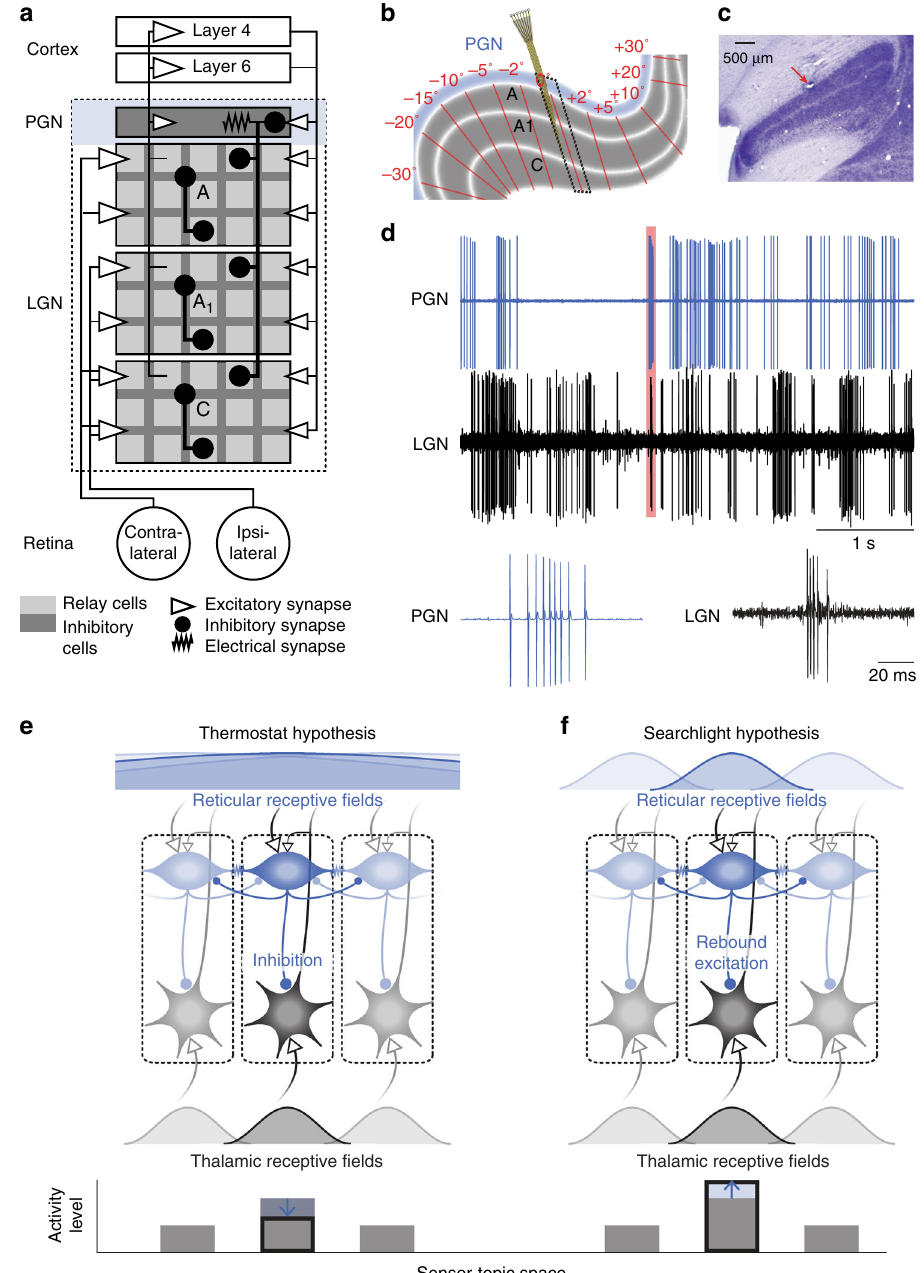
Fig. 1 Neural circuits and sample recordings from the visual thalamus (PGN and LGN) of the cat. a The PGN and main layers of the LGN drawn as rectangles including populations of excitatory ( light fi ll ) and inhibitory neurons ( dark fi ll ). Glutamatergic synapses ( open arrows ); GABAergic synapses ( fi lled circles ) and electrical synapses (resistor). b Parasagittal section of the visual thalamus; the layers of the LGN ( gray ) and the PGN ( blue ). Red lines and corresponding text mark retinotopic position 7 ; dashed box illustrates a single retinotopic location sampled by the multi-electrode. c Nissl-stained coronal section showing a recording site ( red arrow ). d Recordings from a neuron in the PGN ( blue ) and a relay cell in the LGN ( black ) with bursts ( red ) shown at an expanded time scale. Illustrations of the ( e ) thermostat and ( f ) searchlight hypotheses. Boxes with dashed outlines represent local circuits for adjacent regions of the visual fi eld; excitatory, inhibitory, and electrical synapses as above. For the thermostat hypothesis ( e ), reticular feedback has a net inhibitory affect, homogenizing thalamic activity ( bottom bar graph ) by suppressing peaks of activity driven by feedforward input. Because single reticular neurons must sense distributed thalamic activity, their receptive fi elds ( top ) are larger than those of a thalamic relay cell ( bottom ). For the searchlight hypothesis ( f ), reticular feedback exerts a net positive effect, enhancing local activity in the thalamus ( bottom bar graph ) through rebound excitation. Because reticular neurons signal top-down attentional spotlights, their receptive fi elds sizes ( top ) are comparable to those in the LGN ( bottom